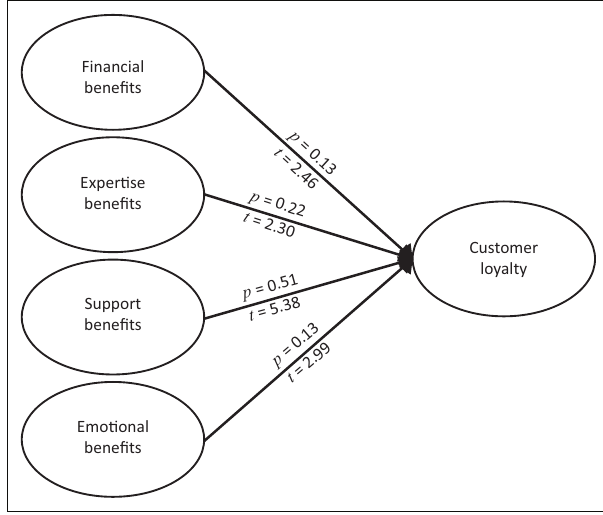
FIGURE 2: Empirical TABLE 6: Items to measure the customer outcome variables. Items